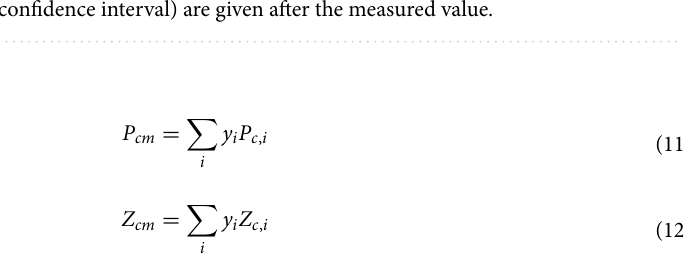
Table 2. Composition of the multi-components gaseous mixtures used in this study. *The absolute measurement uncertainties (95% confidence interval) are given after the measured value.